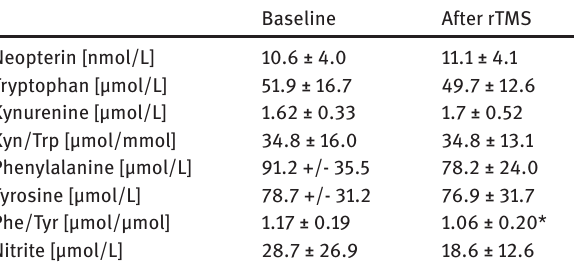
Table 1: Serum concentrations of neopterin and neurotransmitter precursor amino acids (mean values ± SD) in 10 patients with late life depression (Kyn/Trp = kynurenine to tryptophan ratio; Phe/ Tyr = phenylalanine to tyrosine ratio) before and after repetitive transcranial magnetic stimulation (rTMS), *U = 2.081, p = 0.037 (paired rank